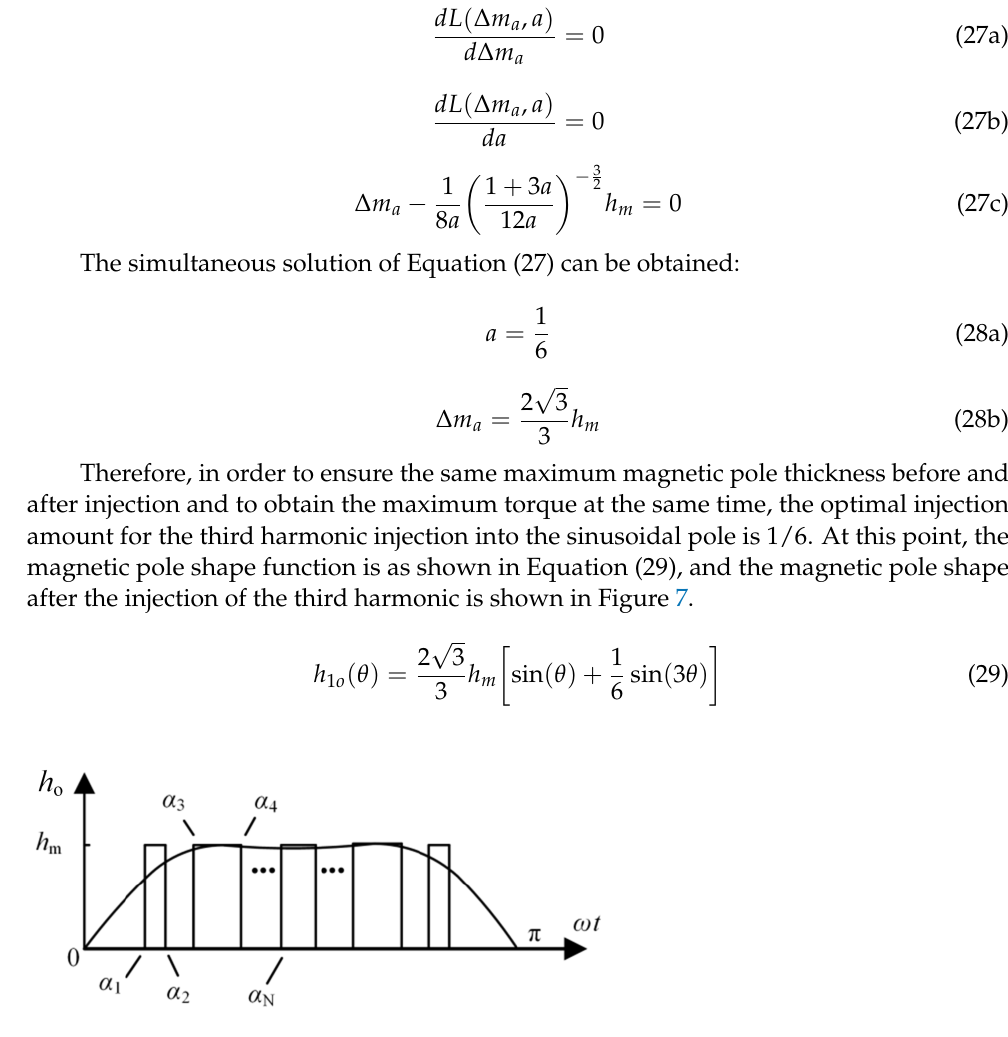
Figure 7. Theoretical waveforms of modulated magnetic poles and 3rd harmonic magnetic poles.